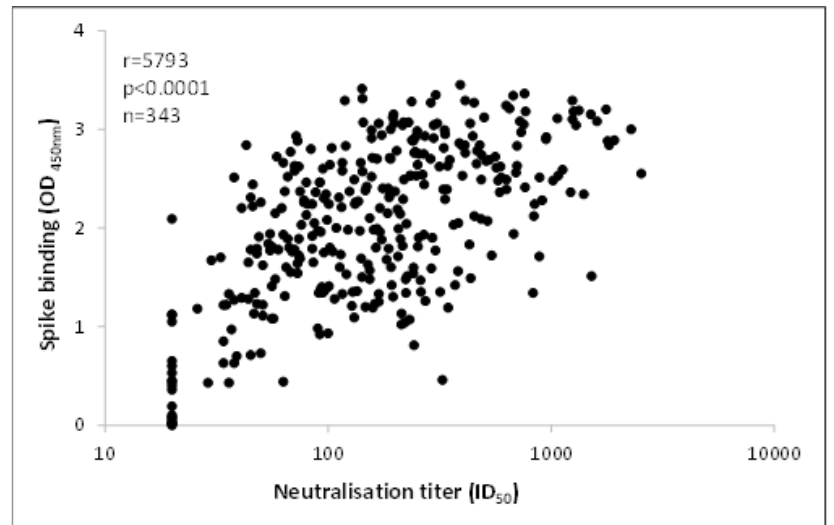
Figure 3. Comparison of neutralizing antibody titers and spike binding antibody responses (Optical Density at 450 nm) of CCP units.